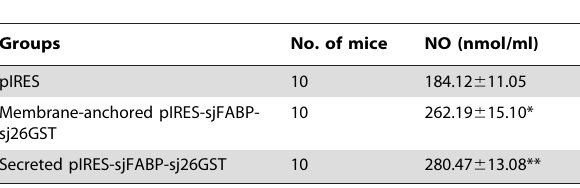
Table 2. Determination of NO in macrophages.